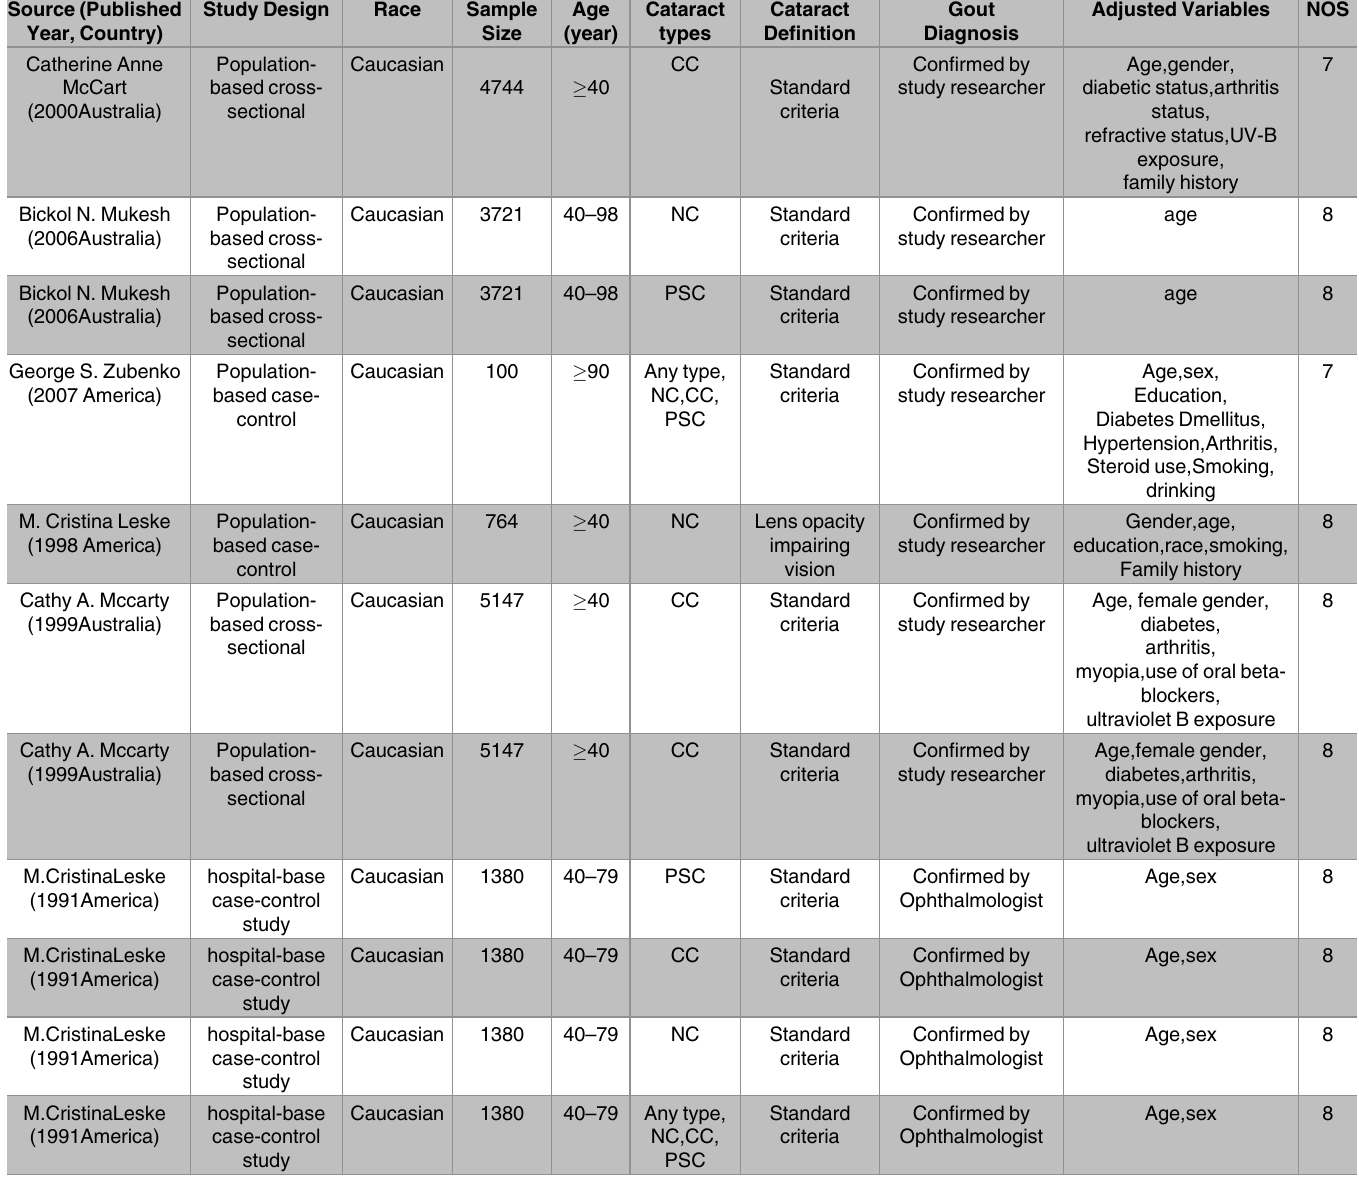
Table 1. Characteristics of 6 studies included into present